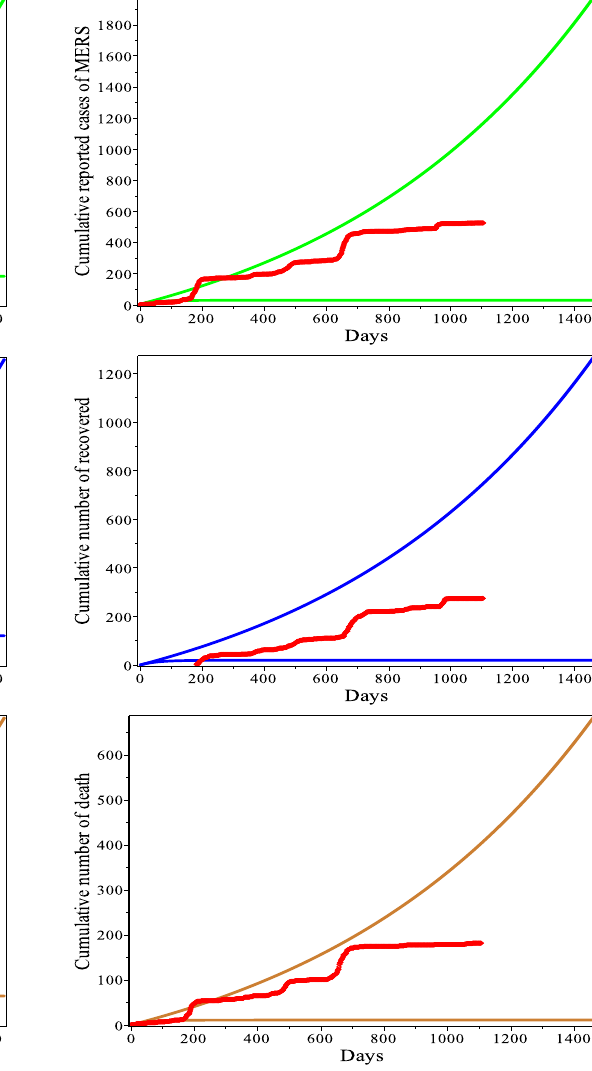
Fig. 8: Variations with respect to γ lead to vari- ations in the cumulative reported cases of MERS (T), cumulative number of recovered (M), and cu- mulative number of death (B) as ω varies randomly in Ω γ so that γ varies in the interval [0 . 144 , 0 . 167] .